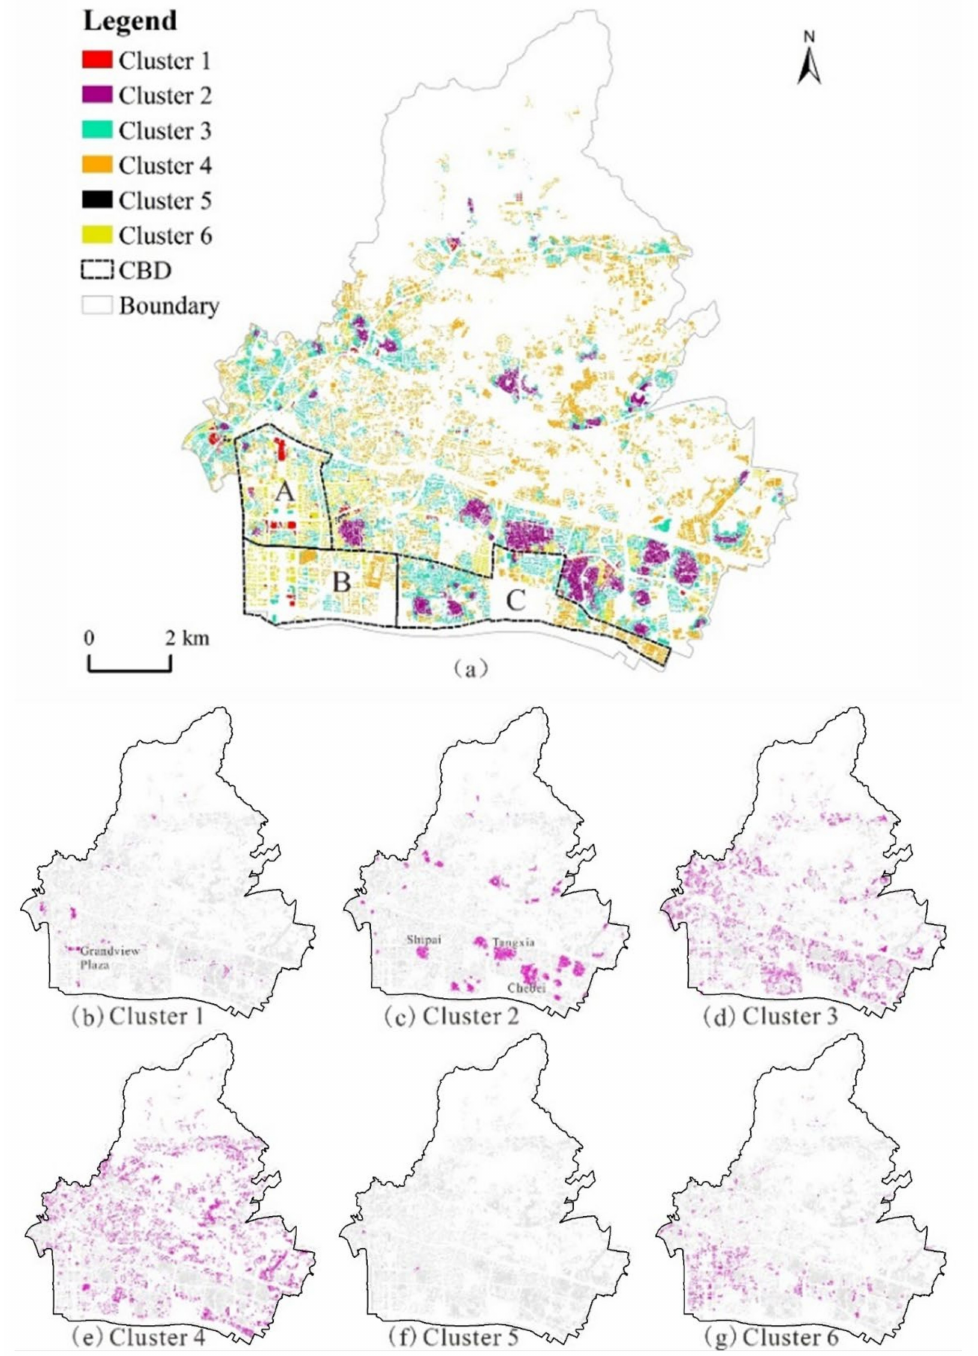
Figure 6. The spatial distribution of the building